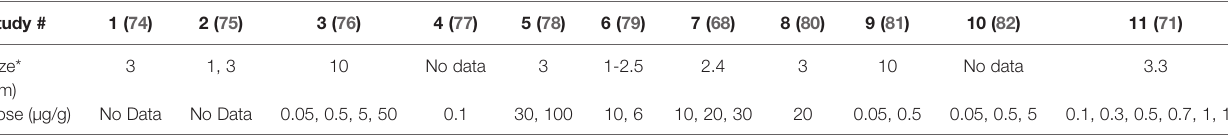
TABLE 2 | Dosing of nanoceria in different in vivo